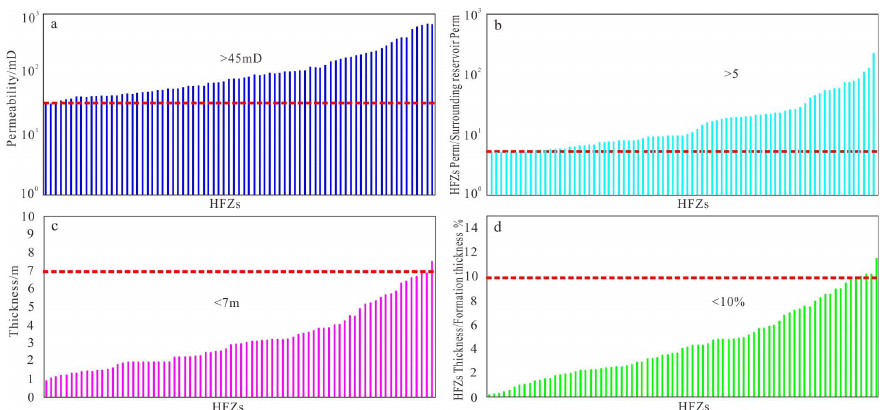
Figure 5. Geological parameters of HFZs in the Mishrif Formation in X Oilfield. ( a ) HFZs permeability range in the Mishrif Formation in X Oilfield; ( b ) permeability ratio of HFZs and surrounding rock in the Mishrif Formation in X Oilfield; ( c ) HFZs thickness range in the Mishrif Formation in X Oilfield; ( d ) thickness ratio of HFZs and surrounding rock in the Mishrif Formation in X Oilfield.